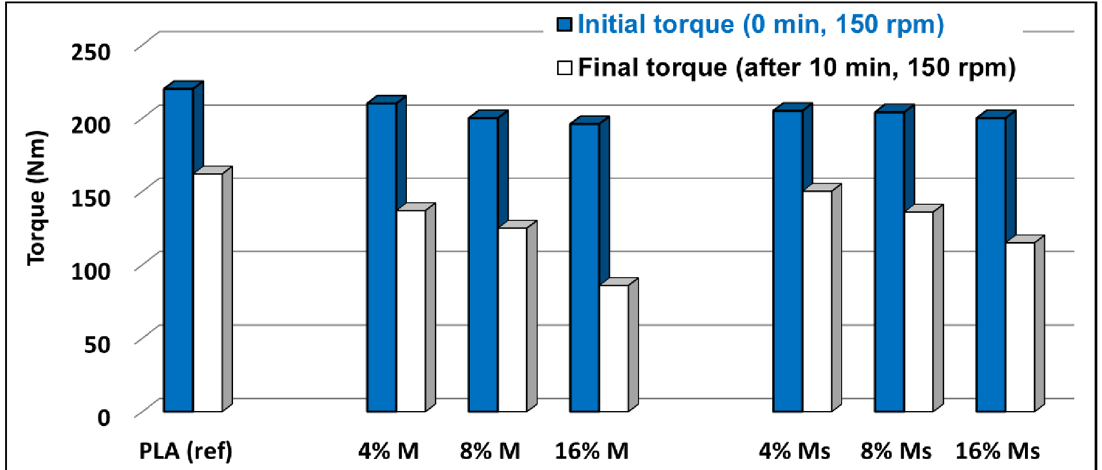
Figure 8. Evolution of torque values during melt-mixing of PLA and of PLA − magnetite nanocomposites. Table 4. Characterization of melt-flow index (MFI; 190 °C, 2.16 kg) of PLA and PLA − magnetite nanocomposites.